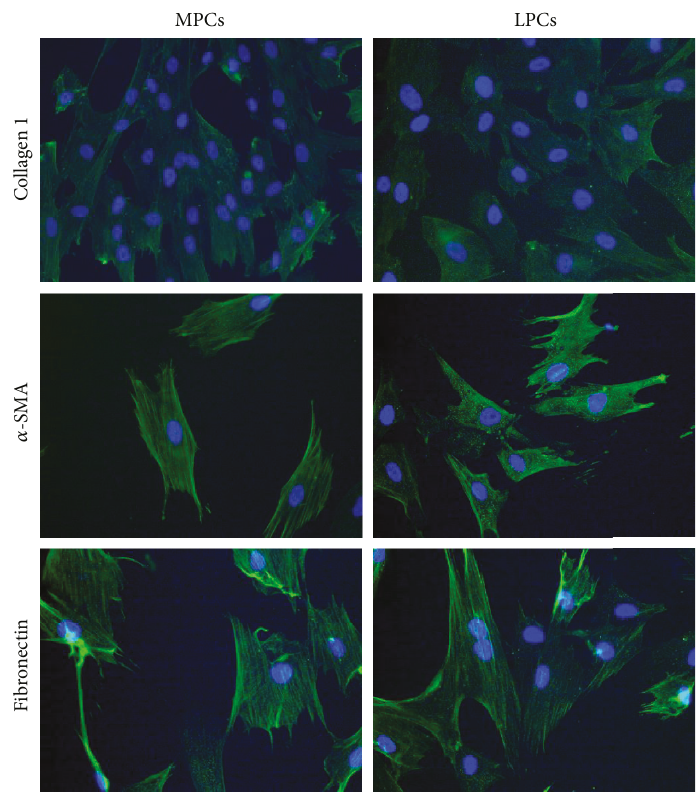
Figure 5: Indirect immuno fl uorescence analysis of α -SMA, collagen type 1, and fi bronectin. A secondary FITC-conjugated antibody was used after incubation with the primary antibodies. Nuclei were counterstained with Hoechst 33342. Myometrium progenitor cells (MPCs) and leiomyoma progenitor cells (LPCs) showed a similarly strong positivity for α -SMA and fi bronectin, whereas collagen type 1 expression was fainter. Di ff erences between MPCs and LPCs were not signi fi cant ( × 200 original magni fi